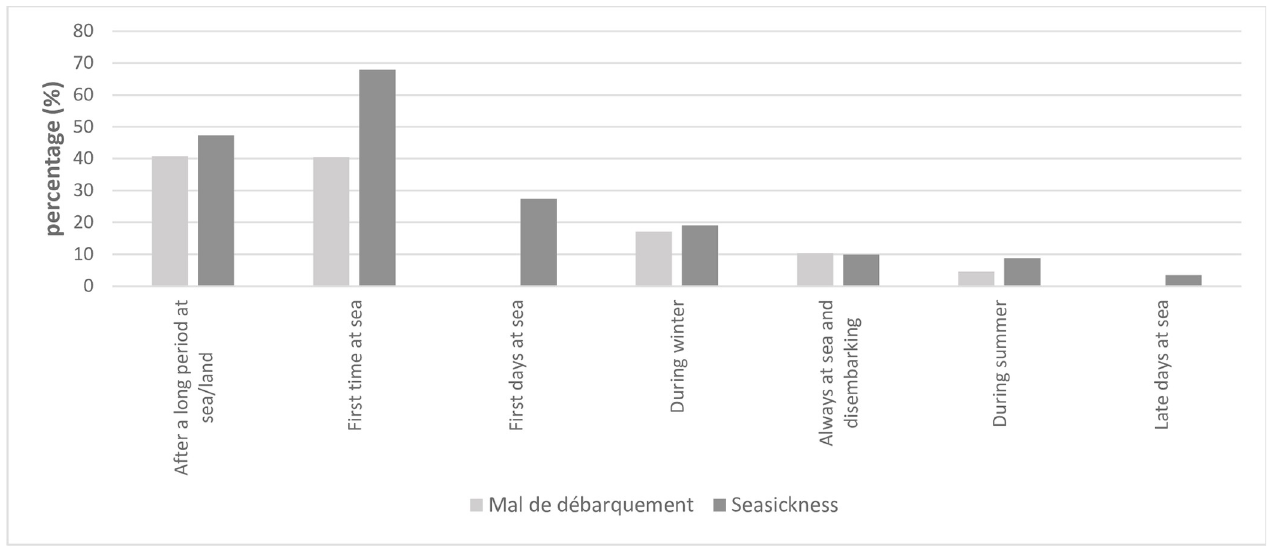
Fig 2. Conditions causing mal de débarquement and/or